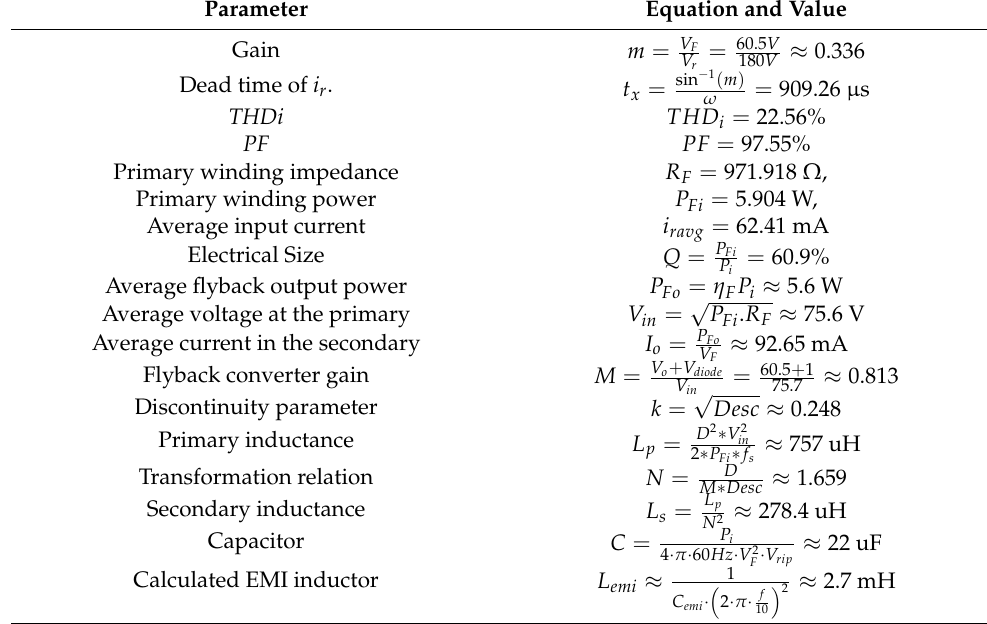
Table 4. Design of the proposed converter.